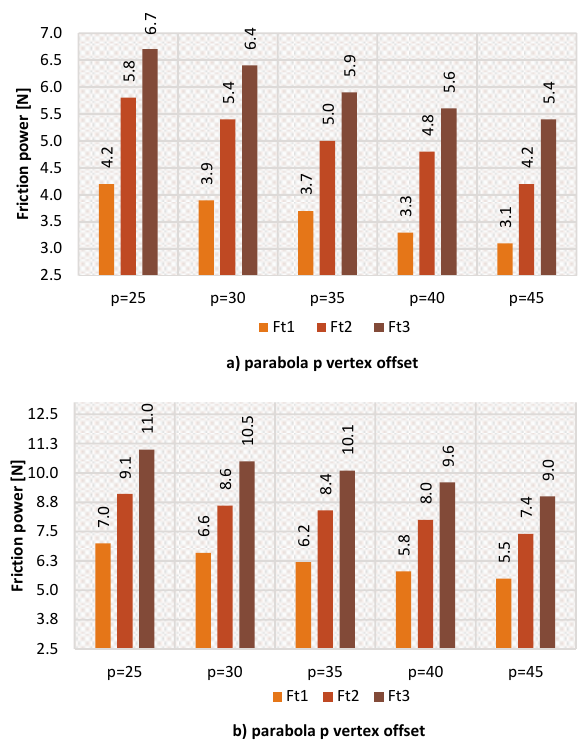
Fig. 3. Friction force at 380° on the crankshaft in the expansion stroke according to the parabolic vertex value of p j,k-1-2 describing the sliding surface shape of the sealing rings, where: F t1 = 1000 rpm, F t2 = 2000 rpm, F t3 = 3000 rpm; a) for the dynamic viscosity of lubricating oil 0.0120 Pa×s, b) for the dynamic viscosity of lubricating oil 0.0386